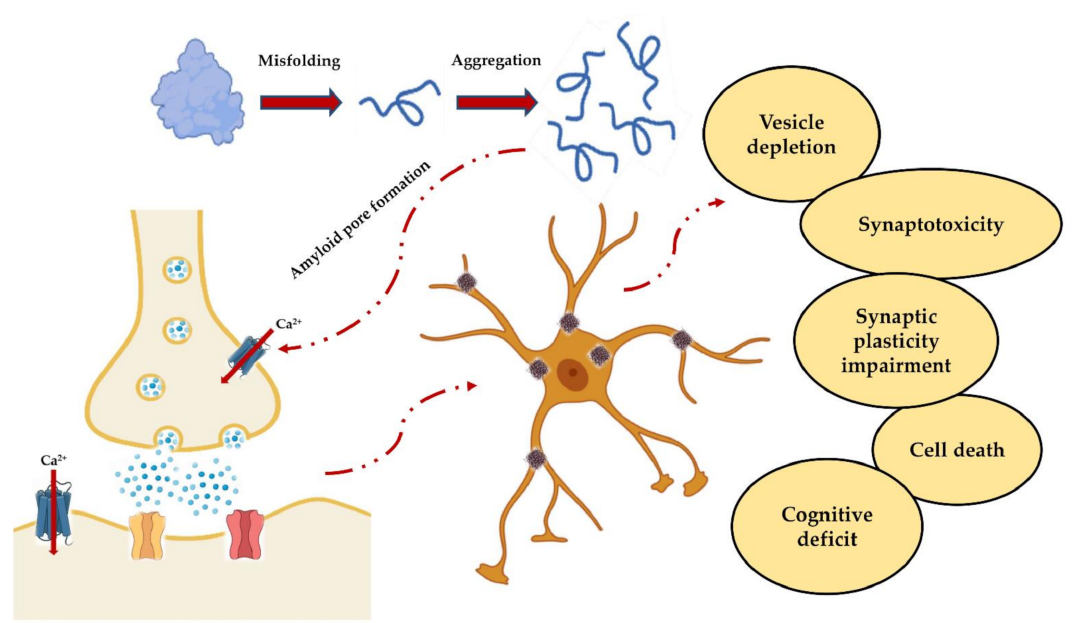
Figure 5. Schematic representation of the events leading to neuronal death and subsequent cognitive impairment. Misfolding and aggregation lead to the formation of PFOs, which not only result in the formation of insoluble fibers that are deposited in the nerve tissue, but also form amyloid pores in the synaptic membrane. The resulting deregulation of the Ca 2+ homeostasis is responsible for the cascade of events that include vesicular depletion, synaptotoxicity, impaired synaptic plasticity and, ultimately, cell death and cognitive